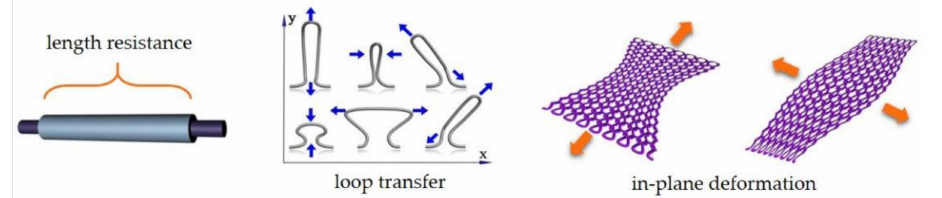
Figure 1. The concepts of length resistance, loop transfer, and in-plane